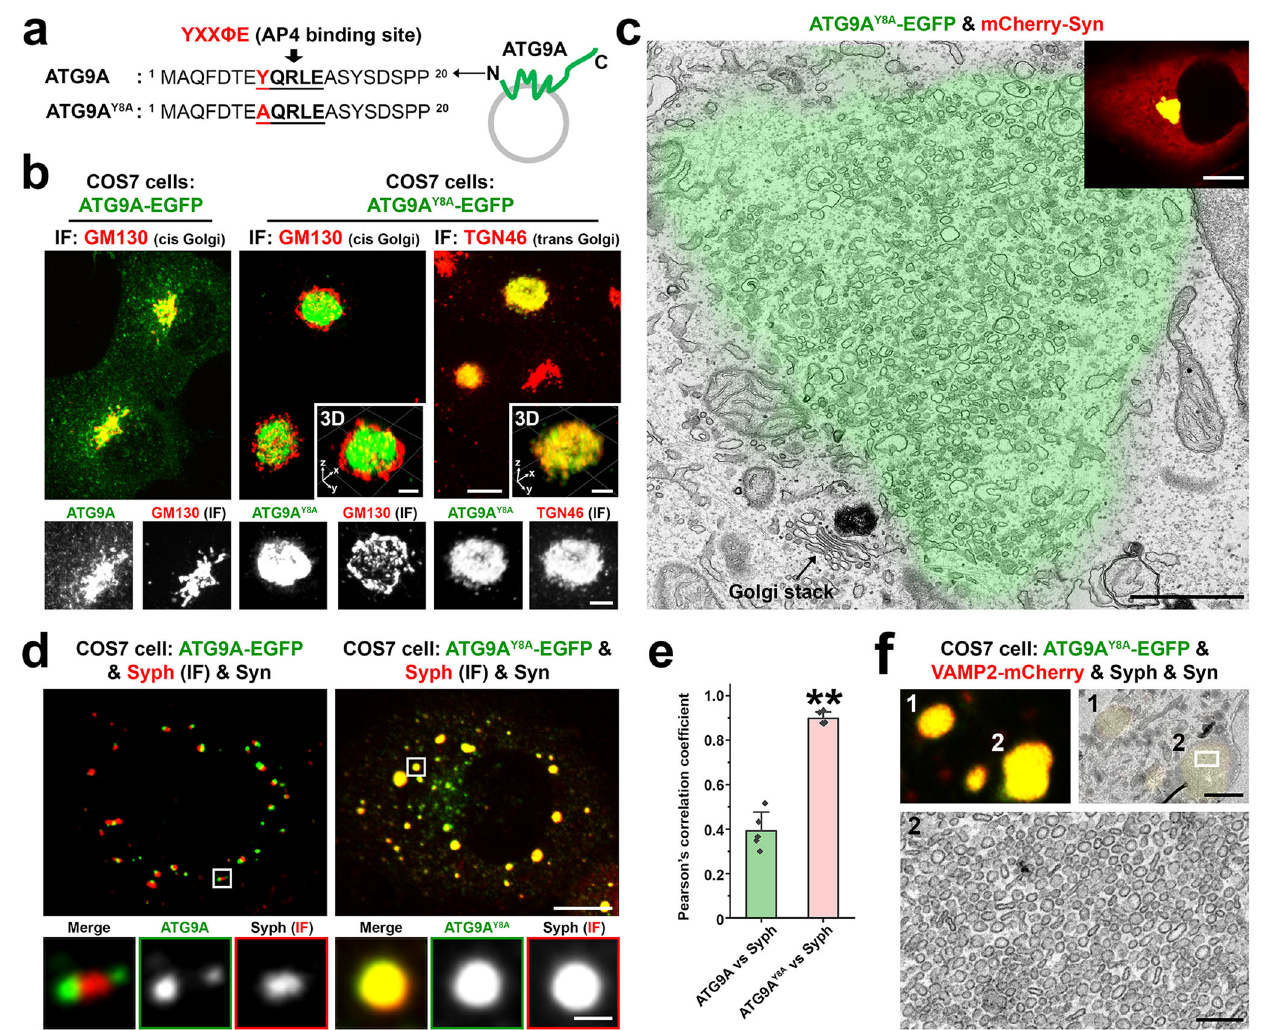
Fig. 7 | Impact of the Y8A mutation of ATG9A on its sorting and segregation fromsynaptophysin.a AminoacidsequenceofthecytosolicN-terminalregionof ATG9A with the AP4-binding motif in bold characters. b COS7 cells expressing ATG9A-EGFP (WT) or ATG9A Y8A -EGFP and immunostained for cis-Golgi (GM130) and trans-Golgi (TGN46) markers, showing that ATG9A Y8A is retained in the TGN area, where it colocalizes with TGN46. See also Supplementary Video 5. c Correla- tive light-electron microscopy (CLEM) of a COS7 cell expressing ATG9A Y8A -EGFP andmCherry-synapsin,showingthattheaccumulationofATG9A Y8A intheTGNarea (green color from the fl uorescence image) correlates with a massive accumulation of small heterogeneously sized vesicular-tubular structures in the same area. An arrow points to a Golgi stack. The inset shows that synapsin is colocalized with ATG9A Y8A in the TGN area, while no sparse droplets positive for ATG9A Y8A and for synapsin are present in this cell. d COS7 cell triple transfected with synapsin,